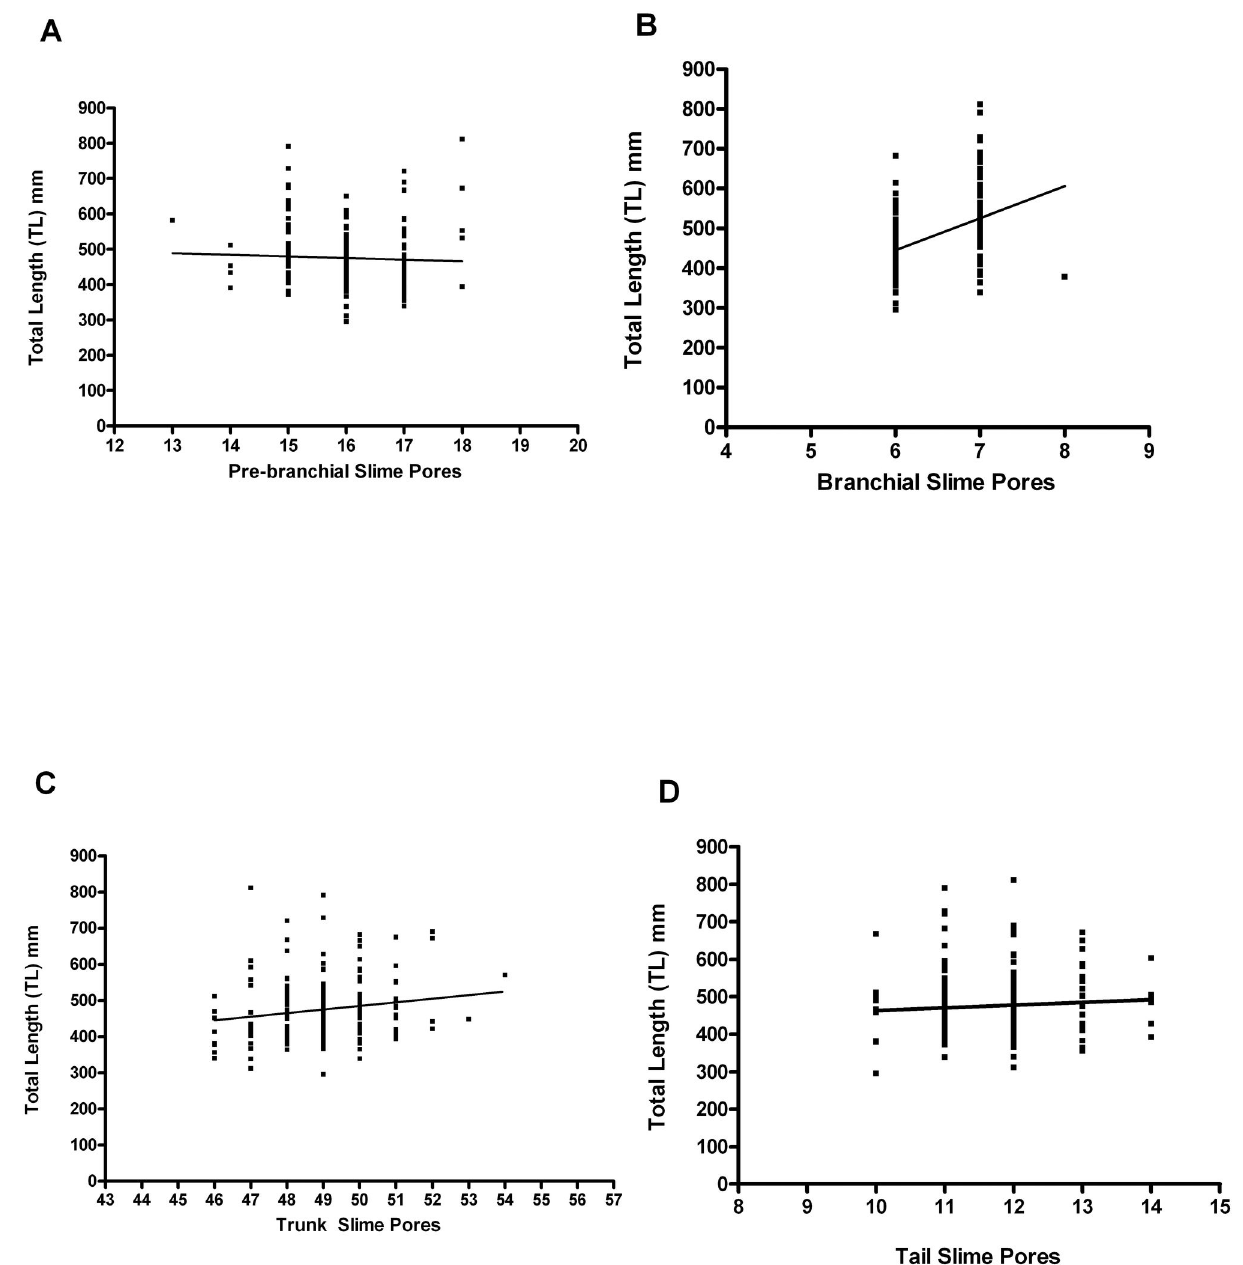
Figure 6. Growth and changes in slime pore number and distribution. (a) Prebranchial slime pore count plotted against TL. The slime pore count in this region does not change significantly with growth. [Pearson r=-0.046; p>0.05, not significant; R 2 =0.002, n =178; mean 16.02, median 16]. (b) Branchial slime pore count plotted against TL. The number of slime pores in the branchial region increases significantly with growth, as 7 slime pores become more common. [Pearson r=0.447; p<0.05*, significant; R 2 =0.197; n =178; mean 6.37, median 6.0]. (c) Trunk slime pore count plotted against TL. The number of slime pores in the trunk increases with growth. [Pearson r=0.165; p<0.05*, significant; R 2 =0.027; n =178; mean 49.0, median 49.0]. (d) Tail slime pore count plotted against TL. The slime pore count in this region does not change significantly with growth. [Pearson r=0.077; p>0.05, not significant; R 2 =0.006; n =178; mean 11.69, median 12.0].